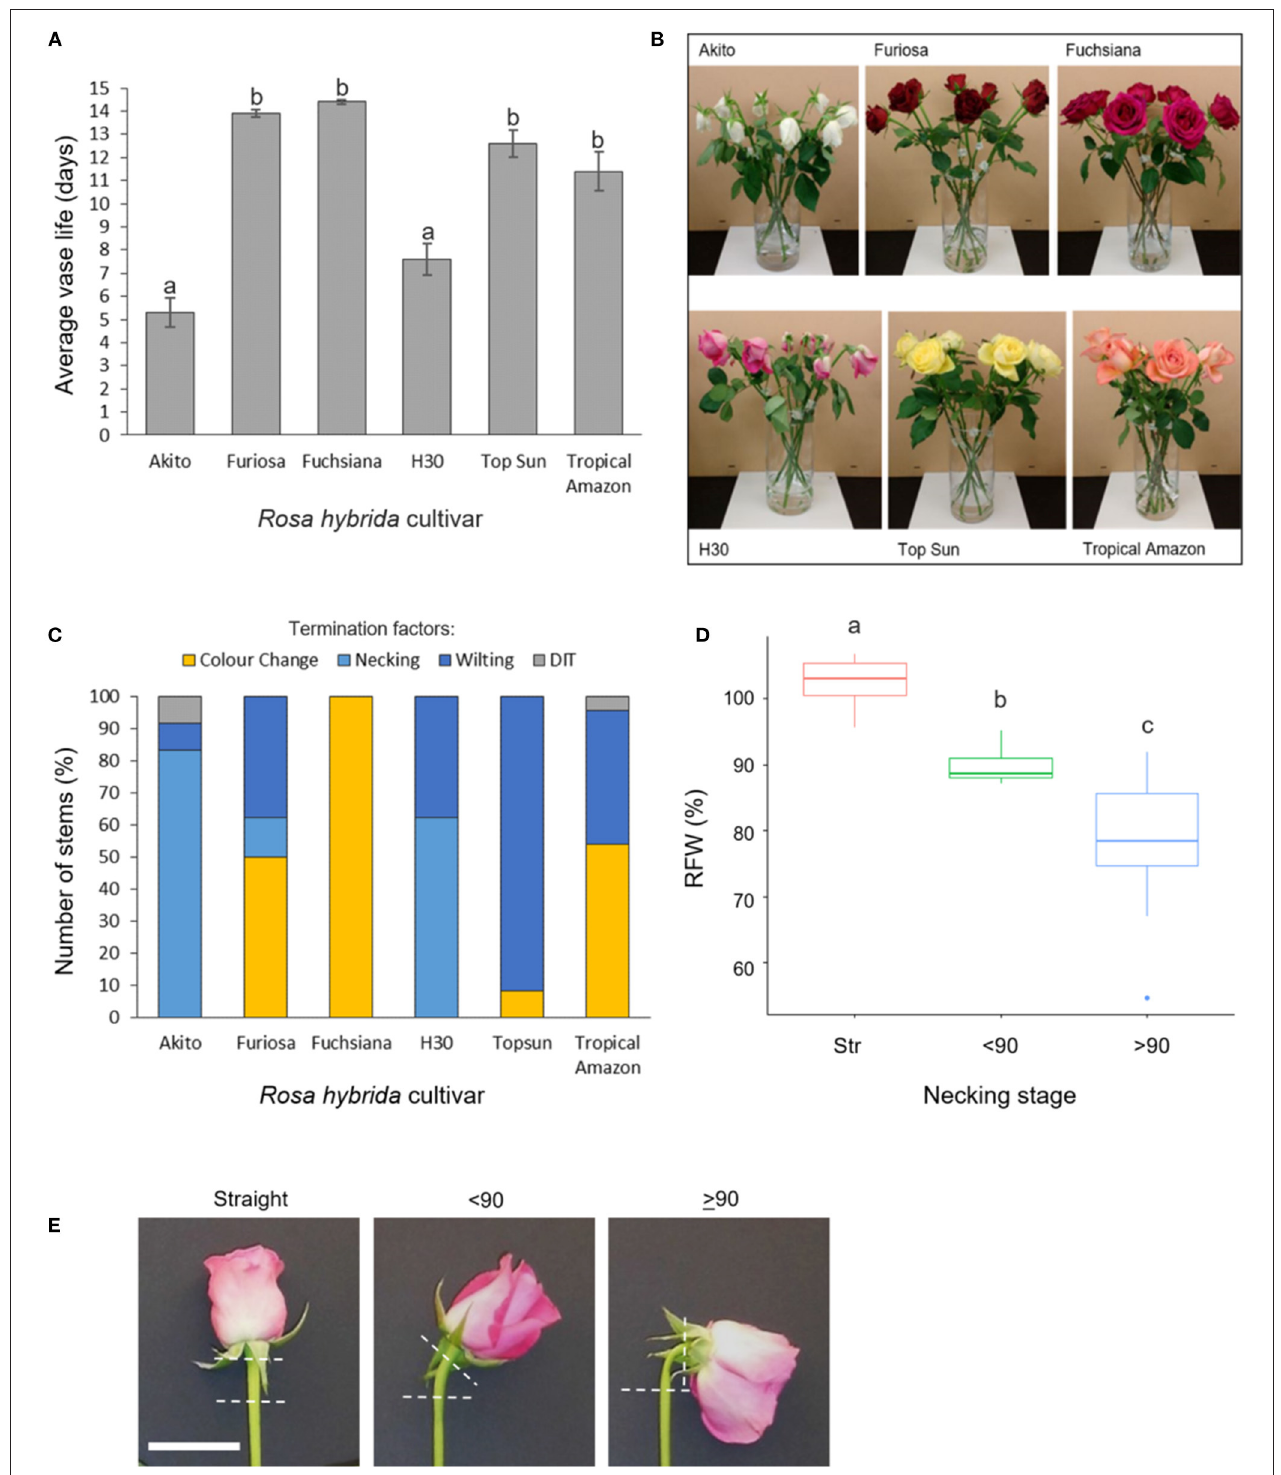
FIGURE 1 | Vase life, incidence, and effects of necking in six Rosa hybrida cultivars (A) vase life (mean ± SE; n = 24); (B) images representative of termination factors seen at day 9 of vase life; (C) termination factors of vase life for each cultivar; color change includes both blueing and browning of petals; DIT, damaged in transit ( n = 24). (D) relative flower head fresh weight of “H3O” and “Fuschiana” rose stems at three necking stages (mean ± SE ; n = 11–21). Different letters indicate significant differences ( p < 0.05), based on ANOVA with a Tukey post hoc test. (E) images of the three necking stages in “H3O” (scale bar = 5cm).